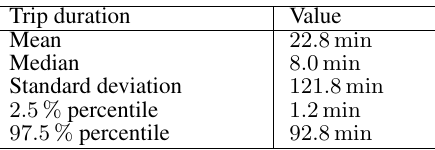
Table 3. Statistical details of all trip durations.